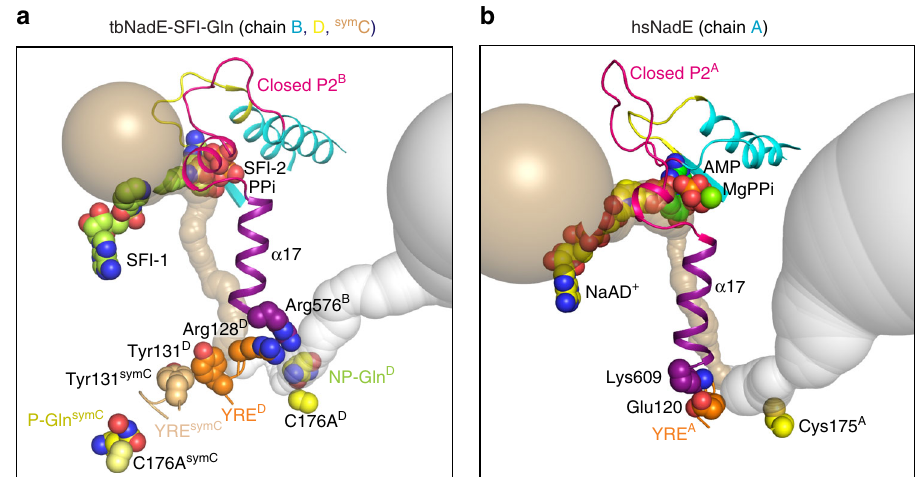
Fig. 6 Comparison of the regulatory elements between the tbNadE and hsNadE complexes. a , b Cartoon structures of the closed P2 loop (cyan), the α -17 helix (purple), and the YRE loop (orange for the coupled subunit, and brown for the uncoupled subunit) in tbNadE – SFI complex bound to glutamine ( a ) and hsNadE ( b ). Panel a shows the α -17 helix connecting the closed P2 loop of B syn to the YRE loop of the coupled subunit D glu . This YRE loop makes also contact with the YRE loop of the uncoupled subunit sym C thus resulting in a productive binding of the glutamine substrate in sym C of tbNadE. Panel b shows the α 17 connects the closed P2 and YRE loops with the same subunit (chain A) in hsNadE. The pairs of Arg128 TB /Arg576 TB and Glu120 HS /Lys609 HS connecting the YRE and α -17 helix of the coupled subunits in tbNadE and hsNadE, respectively, are shown as orange and purple spheres. The Tyr131 TB / symC Tyr131 TB in tbNadE are shown as orange and brown spheres, respectively. The catalytic cysteine and the C176A variant in the glutaminase active site are shown as yellow spheres. The Caver calculated ammonia and glutamine tunnels are shown in golden and gray,